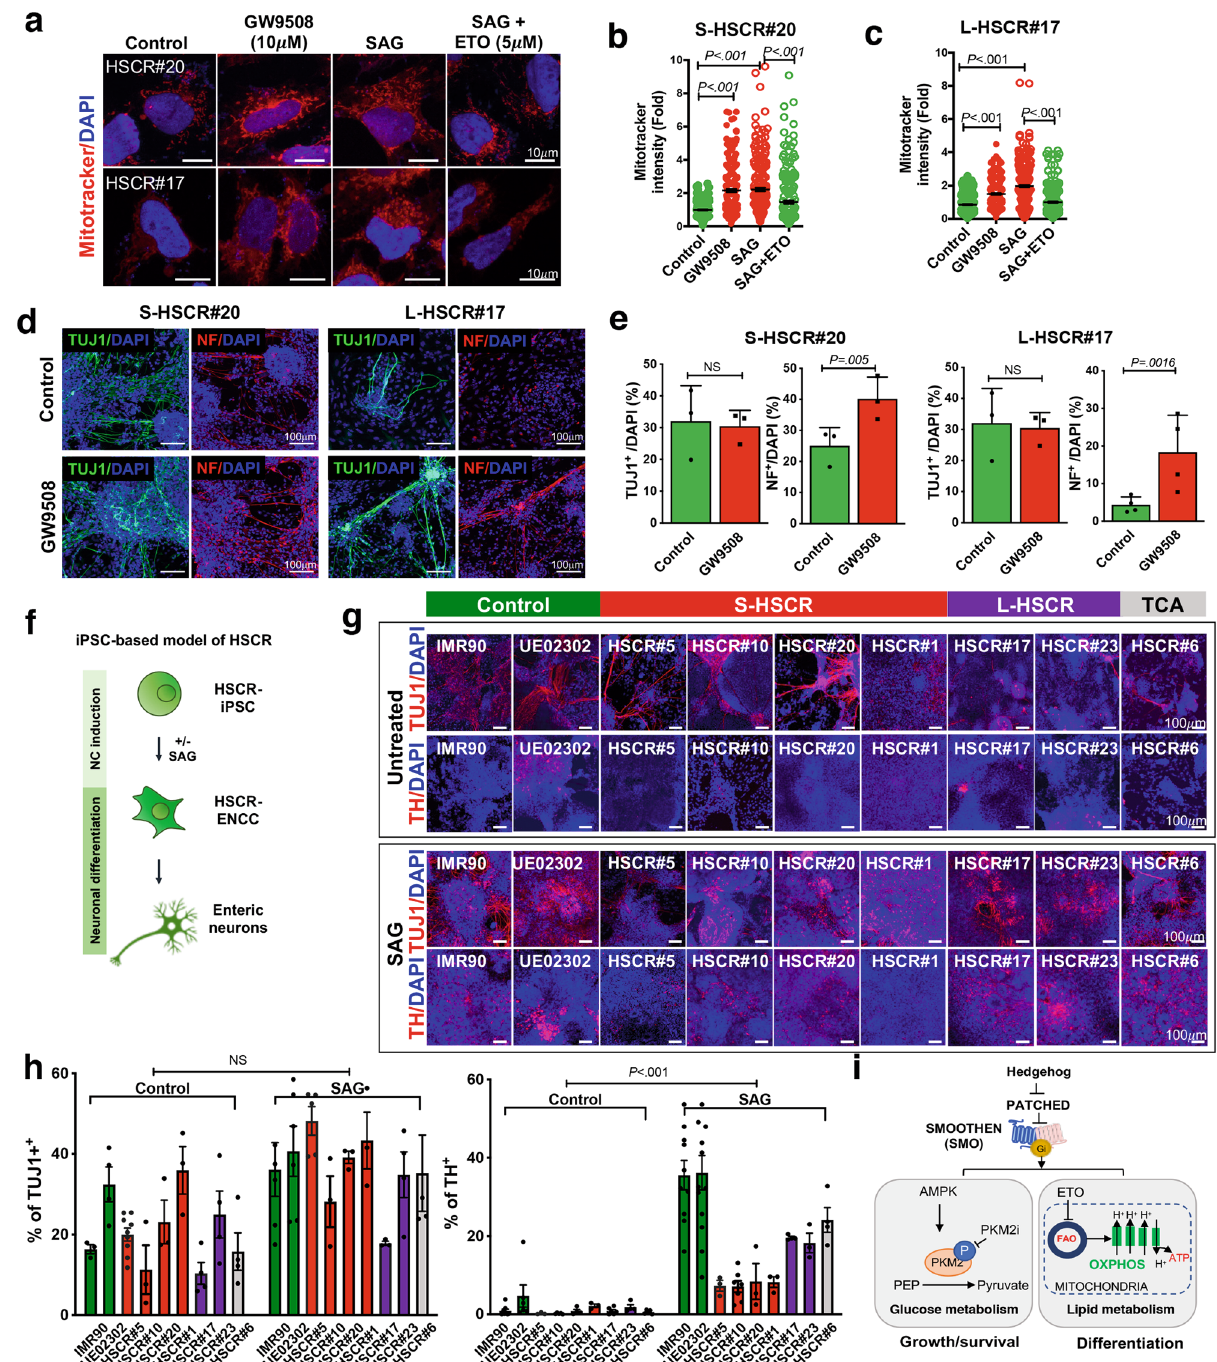
Fig. 7| Hedgehog-inducedOXPHOSrescuesthedifferentiationdefect ofHSCR- ENCCs. a Mitochondria activities in HSCR-ENCCs treated with FAO agonist (GW9508), SAG, and SAG in combination with ETO were monitored using the Mitotracker assay. The corresponding quantitative analyses of mitochondria activities in HSCR#20- and HSCR#17-ENCCs from three independent experiments are shown in ( b , c ). Black lines mark the mean values±SEM. d Immunocytochem- istry of TUJ1 + and NF + neurons on day 5 of neuronal differentiation. e Bar charts showmeanvalues±SEMfrom3 – 4independentexperiments(Student ’ s t -test,two-